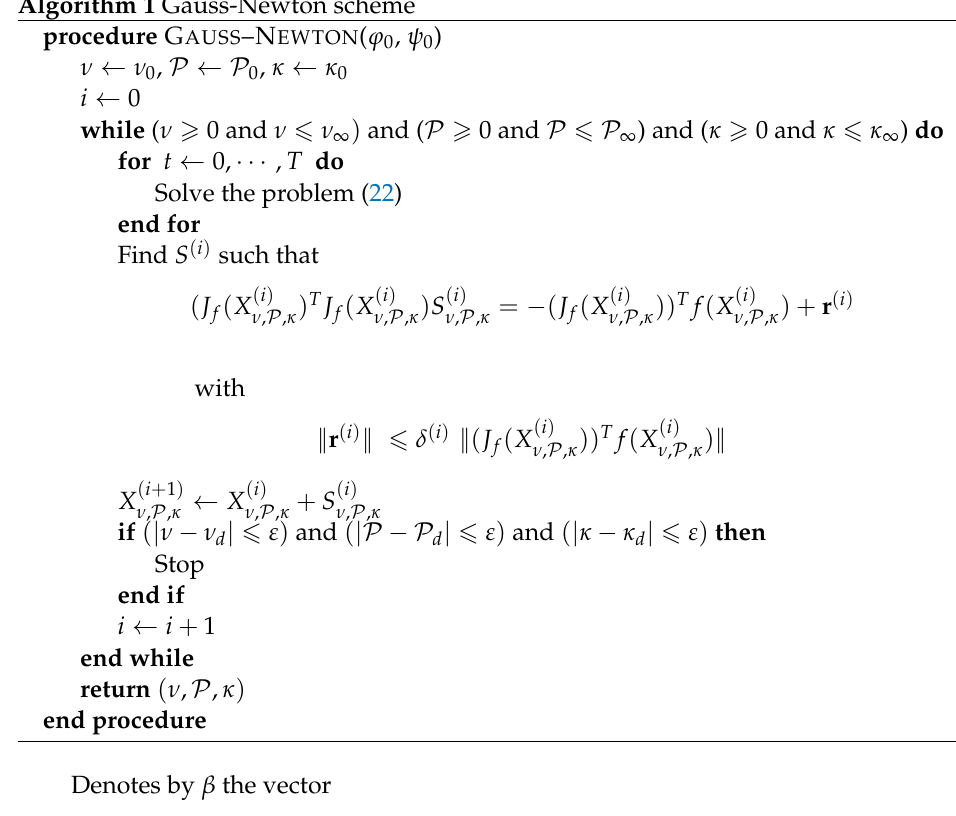
Algorithm 1 Gauss-Newton